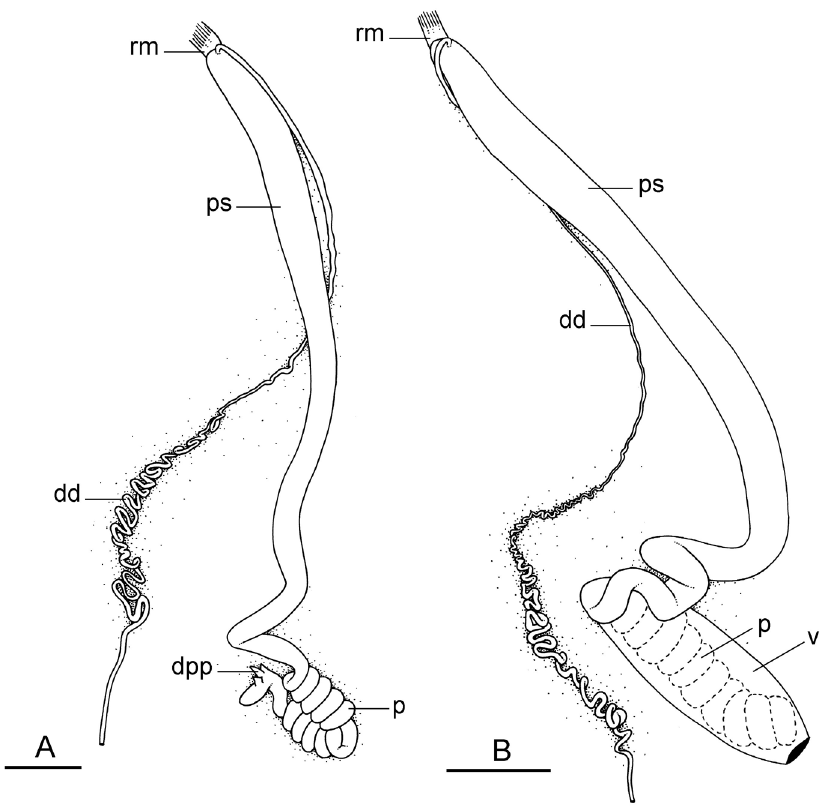
Figure 41. Reproductive system, anterior, male copulatory parts, Wallaconchis ater . A Vestibule re- moved, showing the coiled and U-shaped penis, Indonesia, Sulawesi, scale bar 3 mm [2220] (UMIZ 00050) B Vestibule with coiled penis inside, Philippines, Bohol, scale bar 3 mm [3270] (PNM 041220). Abbreviations: dd deferent duct dpp distal penial projections p penis ps penial sheath rm retractor muscle v